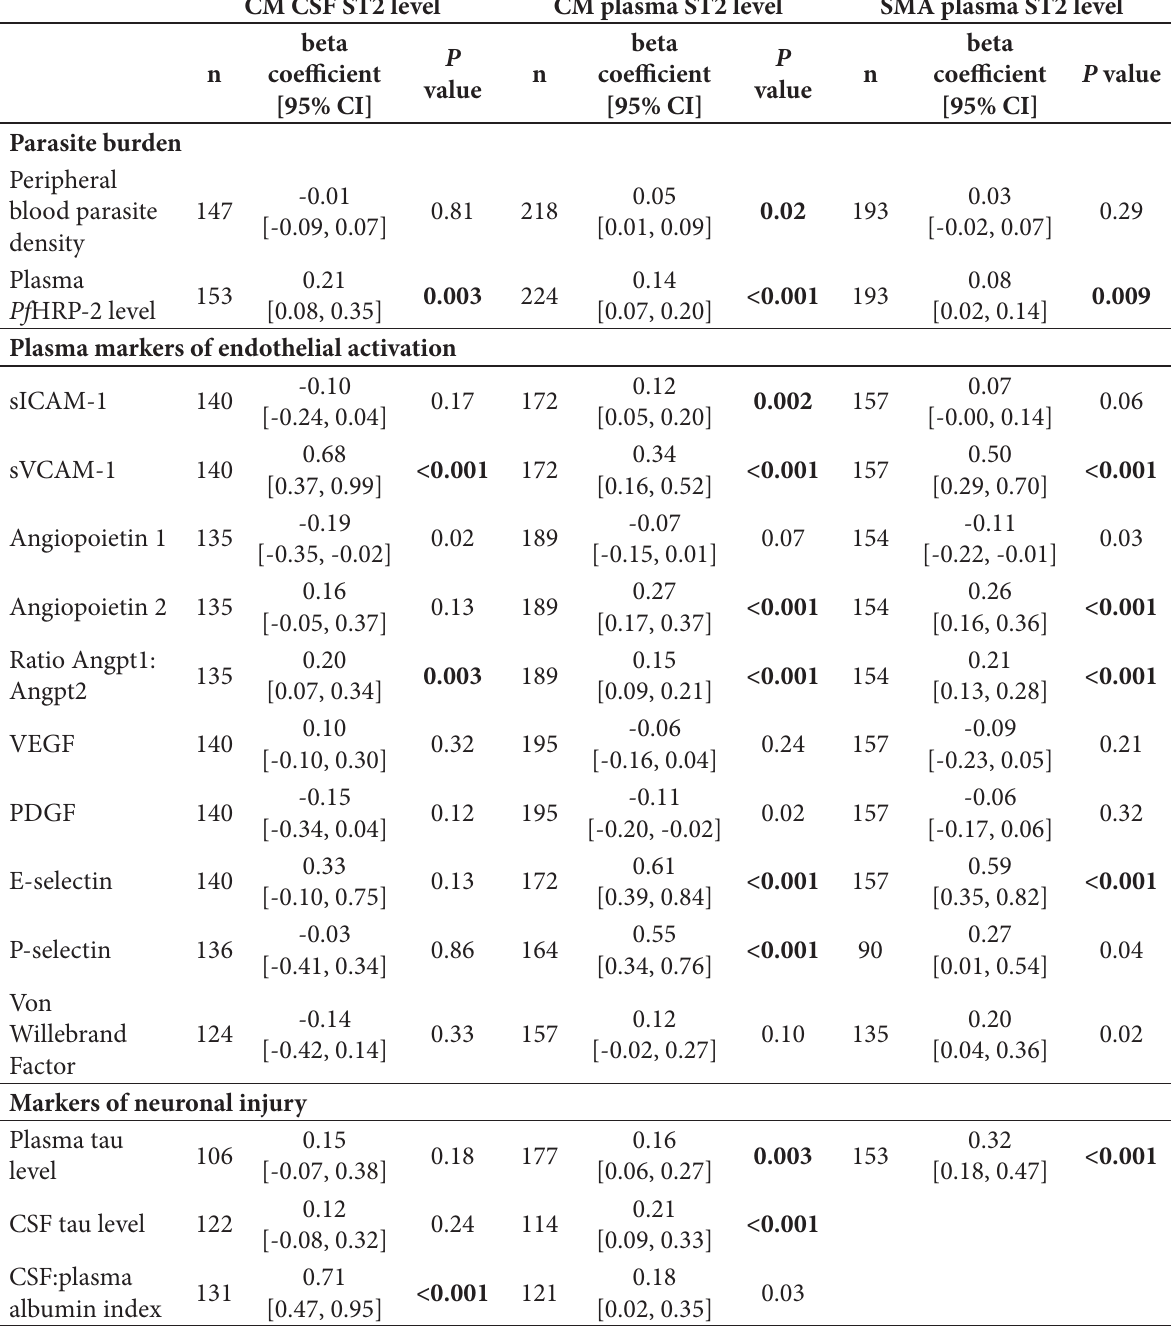
Table 1. Associations between plasma and CSF levels of sST2 and parasite and host response factors in children with cerebral malaria (CM) or severe malarial anemia